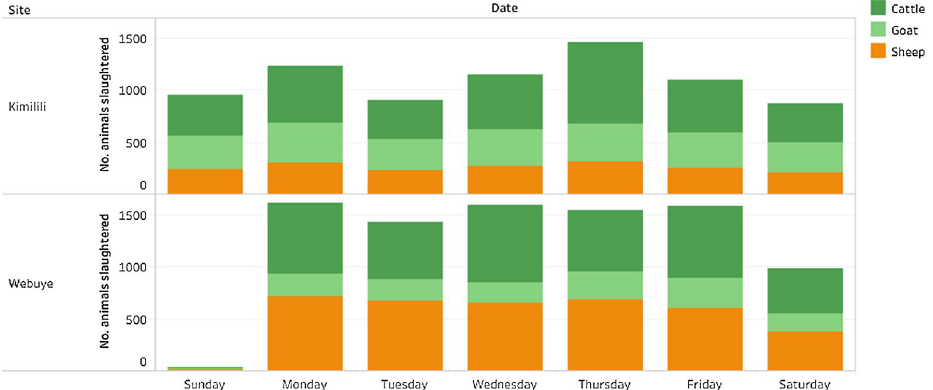
Figure 3. The number of reports submitted on each weekday by the meat inspectors in two slaughterhouses in Bungoma County, western Kenya, between 17th March 2017 and 31st December 2019.